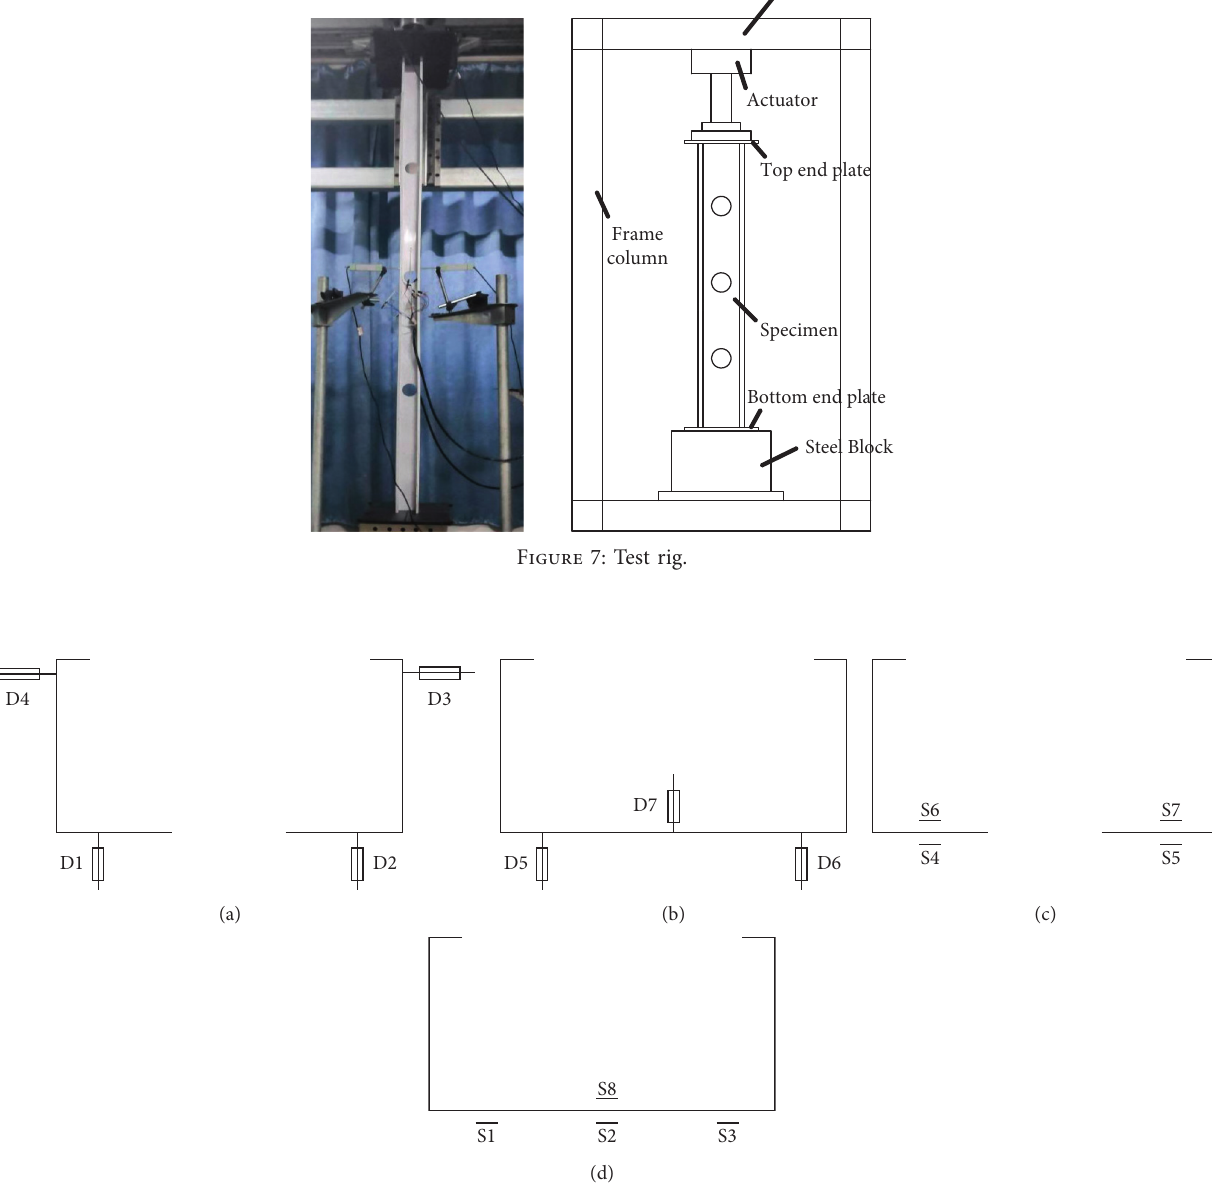
Figure 8: Instrumentation arrangement. LVDTs for specimens (a) with holes and (b) without holes. Strain gauges for specimens (c) with holes and (d) without